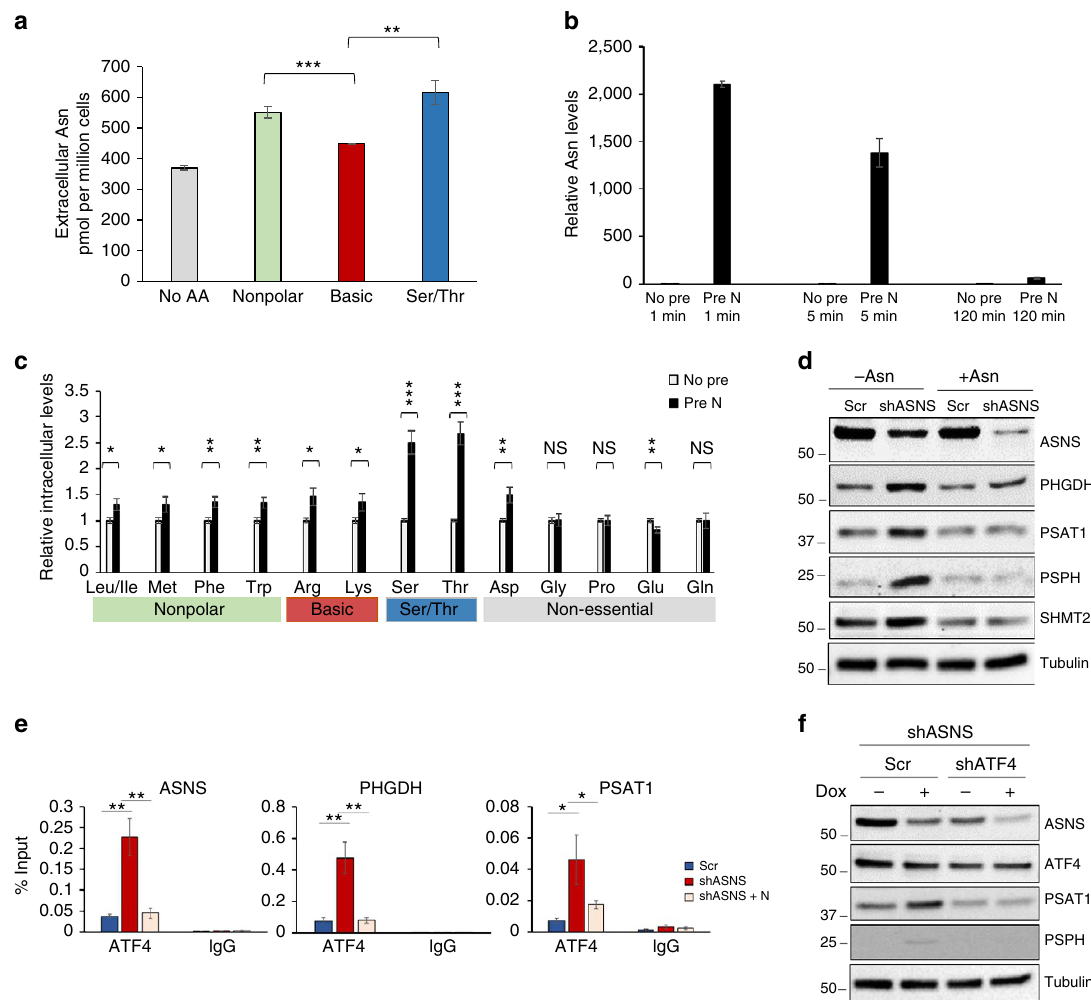
Figure 4 | Asparagine levels regulate serine uptake and serine metabolism gene expression. ( a ) Asparagine levels in the media, measured by LC-MS, from serum- and amino acid-starved LPS2 cells pre-loaded with asparagine (Pre N) and unstimulated (No AA) or stimulated with different amino